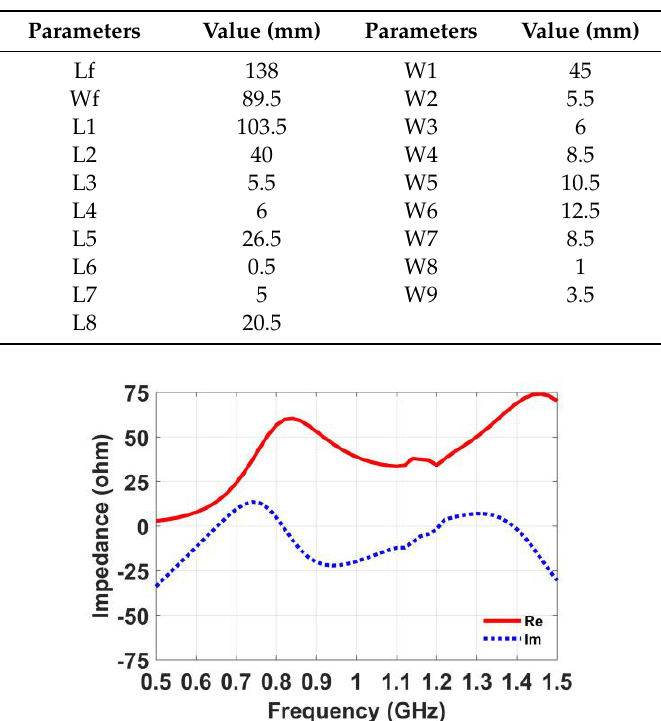
Figure 8. The geometry of the proposed UHF antenna. Table 1. Design parameters of the proposed UHF antenna.